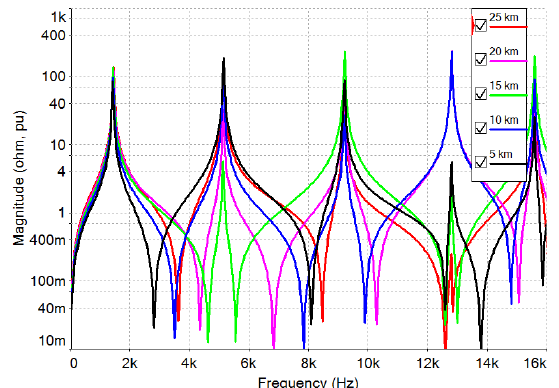
Figure 5. Magnitude (in ohm, pu) of the impedance seen by the pantograph terminals as a function of the frequency and the distance of the train from the substation, with a section length of 30 km.